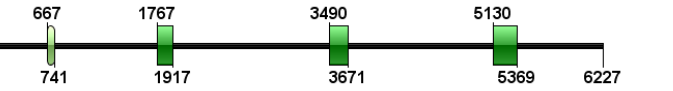
Figure 1. cDNA and deduced amino acid sequence of igf2. The positions of the cDNA and deduced amino acid sequences are shown by numbers on the left. The signal peptide is presented as a wavy line. The IGF domain is in yellow. The IGF2_C domain is underlined. The SNP is in red.